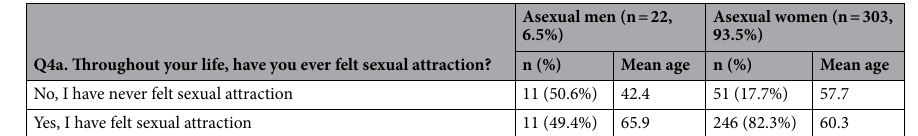
Table 2. Percent number and mean age of Asexual men and women for each option of Q4a. Percentages and means were design-adjusted.